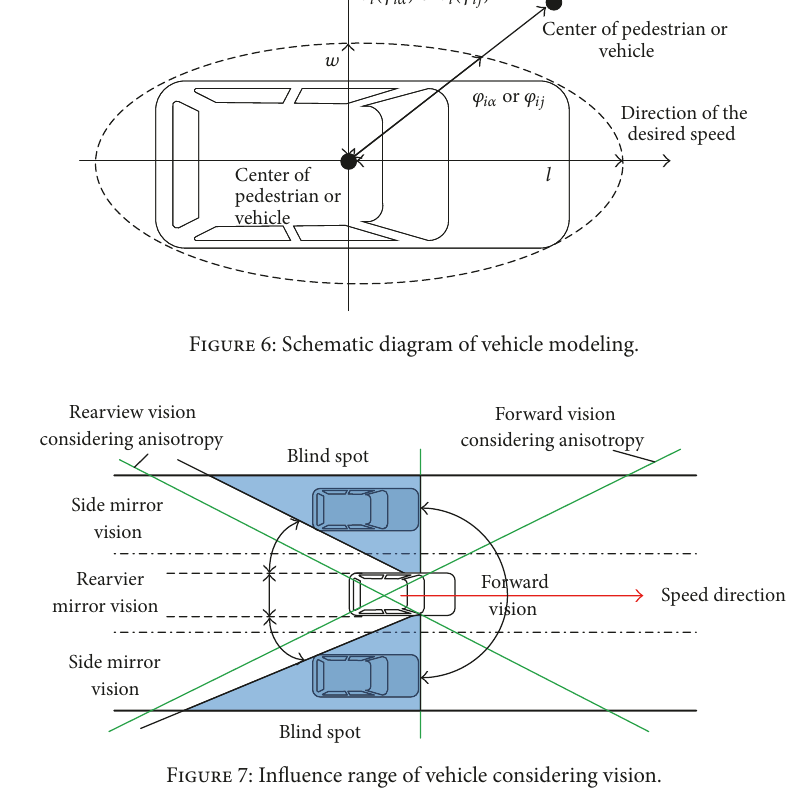
Figure 7: Influence range of vehicle considering vision.